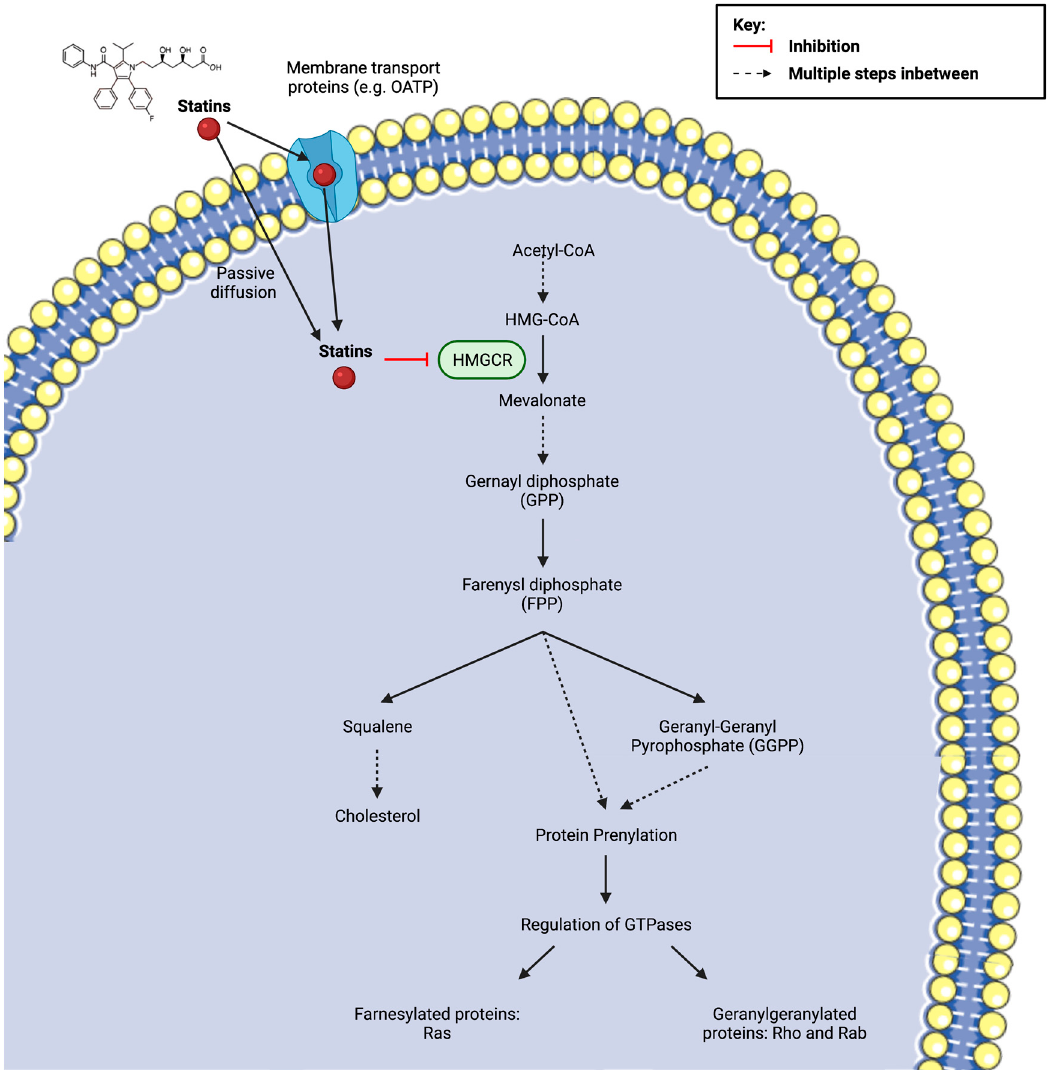
Figure 2. Statin inhibition of 3-hydroxy-3methylglutaryl coenzyme A (HMG-CoA) reductase (HMGCR) and the subsequent implications on downstream metabolites of the mevalonate pathway, including the synthesis of cholesterol and the isoprenoids farnesyl pyrophosphate (FPP) and geranyl- geranyl pyrophosphate (GGPP). Protein prenylation, via isoprenoids, is essential for the activation of small guanosine triphosphate (GTP)-binding proteins (Ras, Rho, Rac). The cellular uptake of the drug depends on its solubility. Lipophilic statins are more likely to enter the cell via passive diffusion, whereas hydrophilic statins require protein transporters, such as organic anion transporting polypeptides (OATPs) in hepatocytes. Created with BioRender.com (accessed on 7 March 2022) and Smart.Servier.com (accessed on 7 March